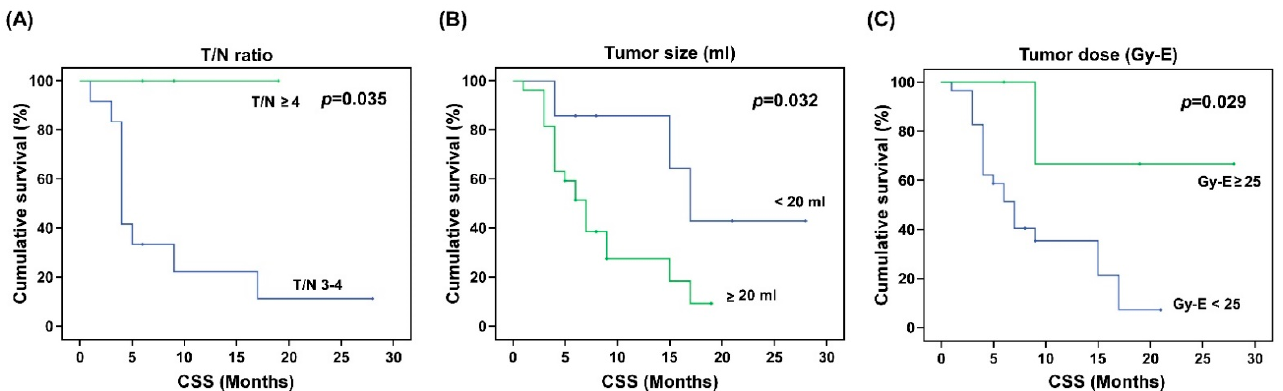
predicted poor overall survival (OS), cancer-specific survival (CSS), and relapse-free survival (RFS).